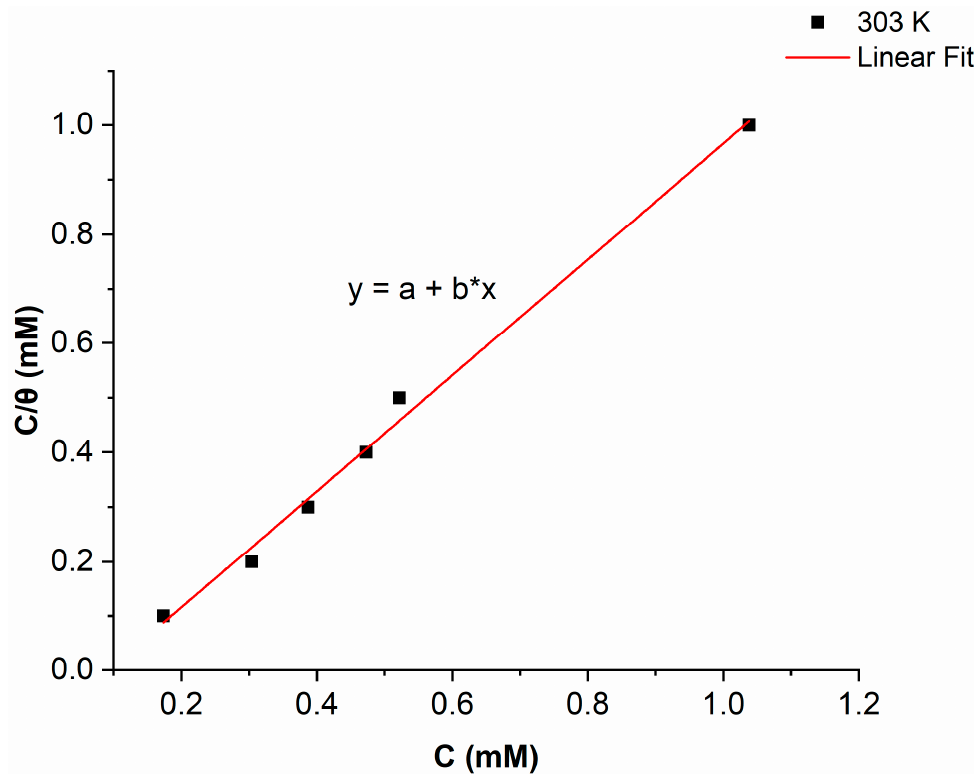
Figure 5. Langmuir adsorption isotherm for mild steel with the addition of the nicotinehydrazide derivative. In order to determine the free energy ∆ G o of adsorption, a linear straight fitted plot ads between C / θ and C was used to determine the K ads